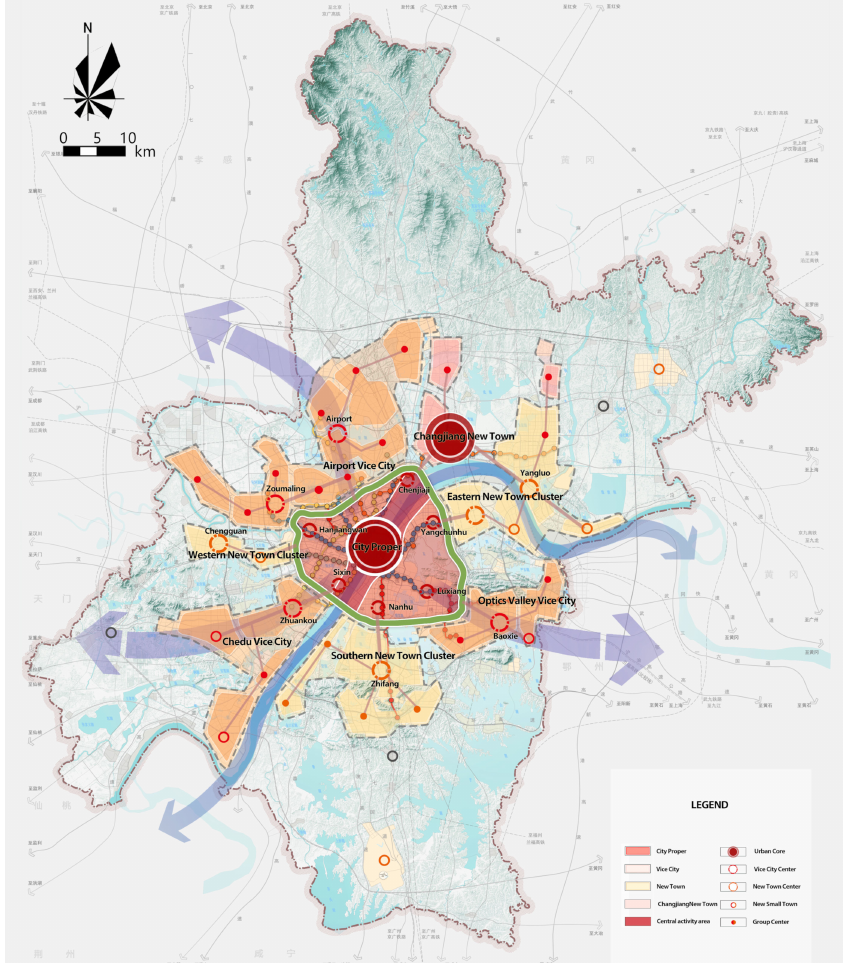
Figure 6. Space structure planning map of